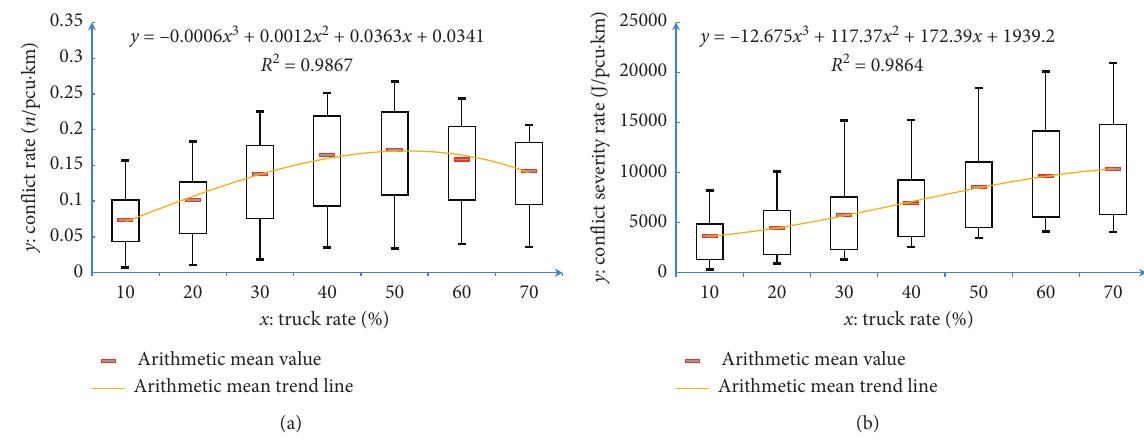
Figure 11: Distribution of traffic conflict rates and severity rates under different truck rates.